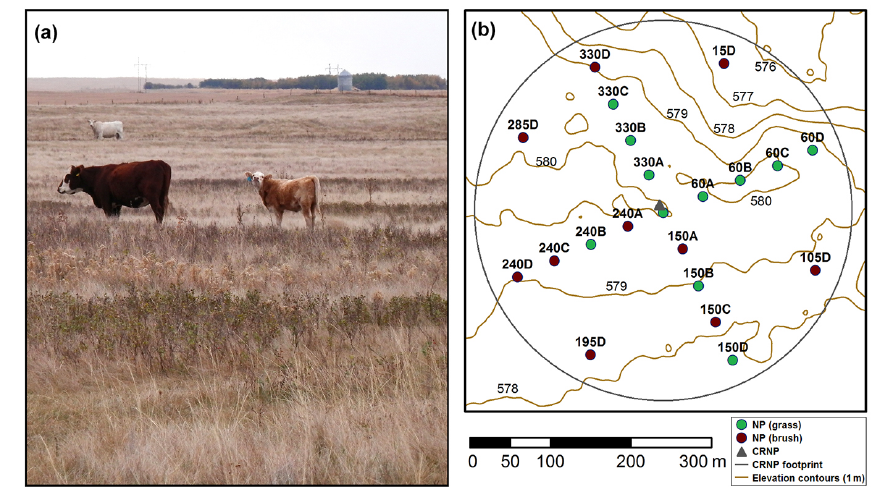
Figure 1. Experimental site: (a) photo of the pasture, and (b) map showing elevation contours and the locations of soil moisture instrumen-